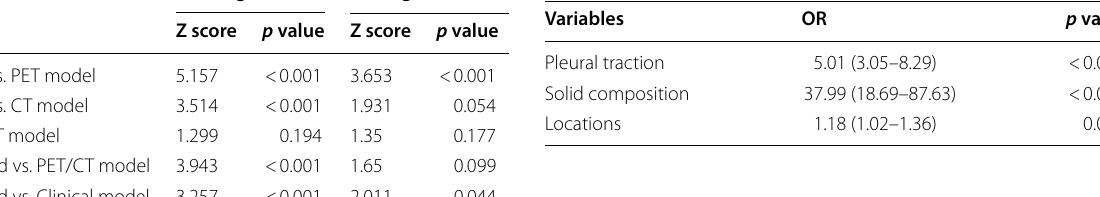
LNM (Table 2). The AUC values of the training and test groups were 0.95 (95% CI: 0.93–0.97) and 0.94 (95% CI: 0.89–0.97), respectively. The AUC values of the PET/CT